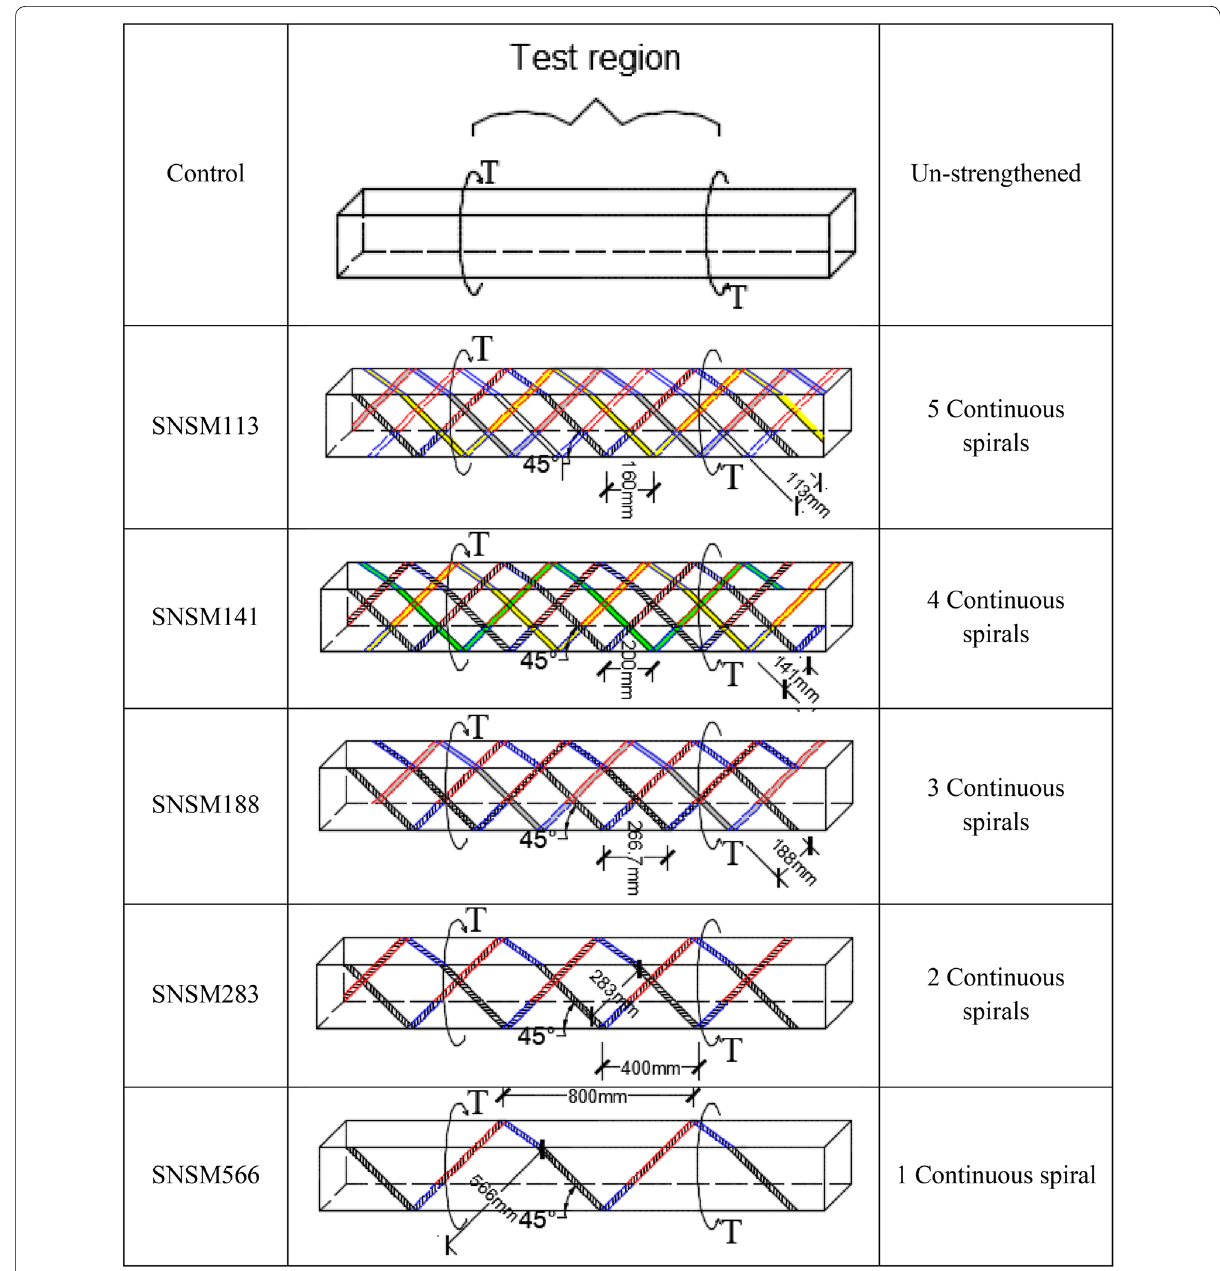
Fig. 2 Strengthening of the test beams.